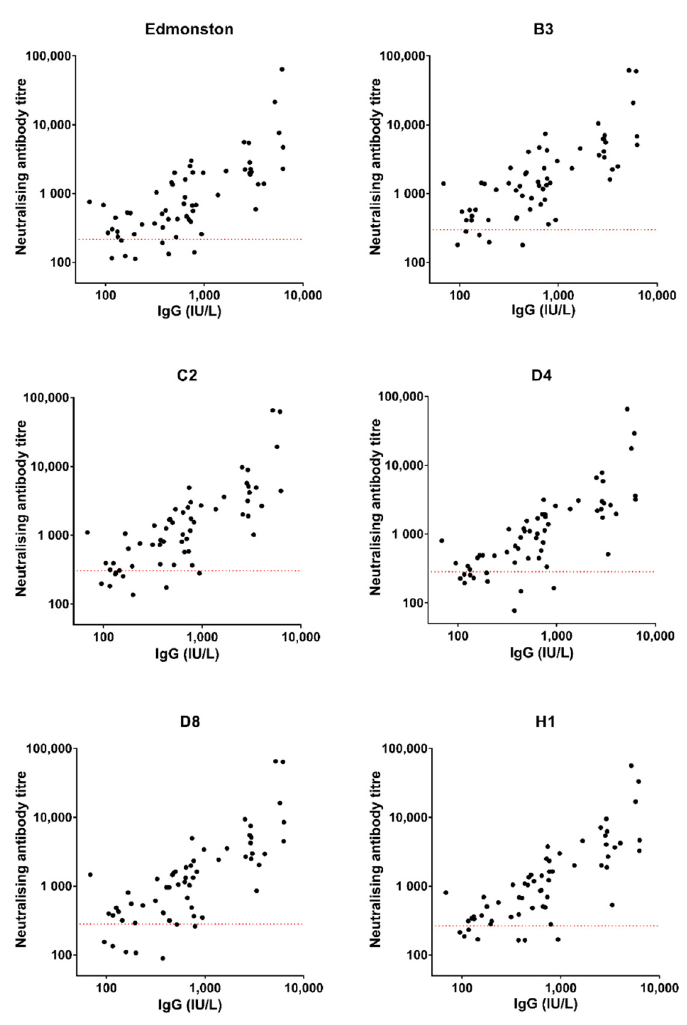
Figure 3. Measles-specific IgG levels (measured by kit from EUROIMMUN ® ) and neutralising antibody titres in Sheffield HCWs. The dotted red lines indicate the titre of the 3rd WHO reference serum (NIBSC 97/648) diluted to 120 mIU/mL, defined as the protective threshold. Table 3. Spearman’s rank correlation coefficient between IgG levels (measured by kit from EURO- IMMUN ® ) and neutralising antibody titres.